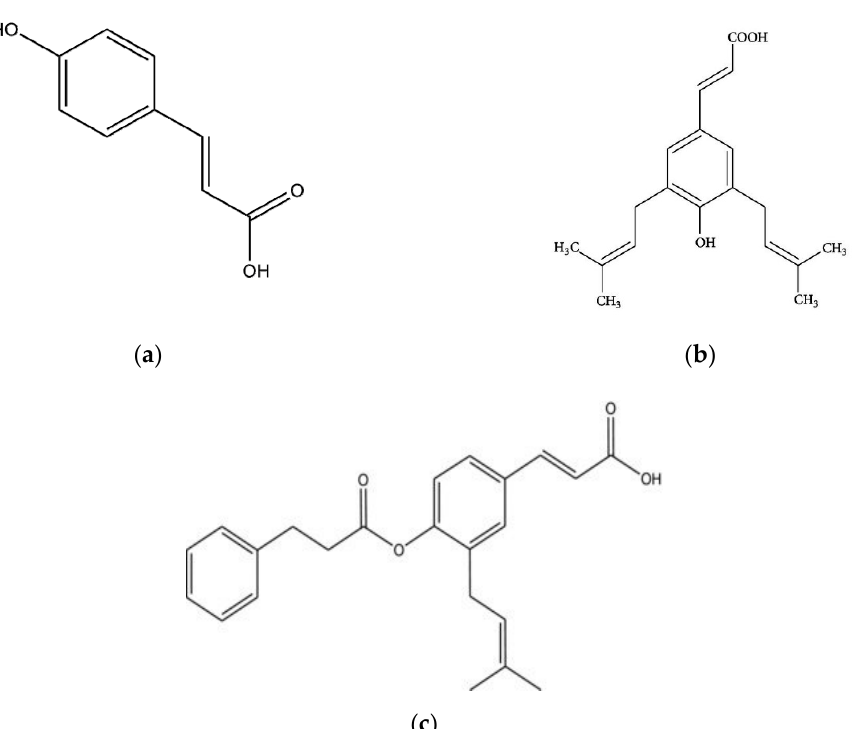
Figure 2. Chemical structure of the main green Brazilian propolis markers ( a ) para-coumaric acid; ( b ) artepillin C; ( c ) baccharin.